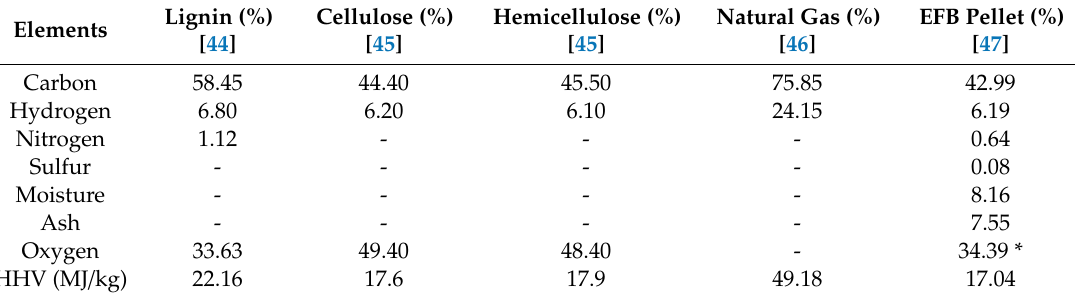
Table 2. Elemental compositions of fuels used for the